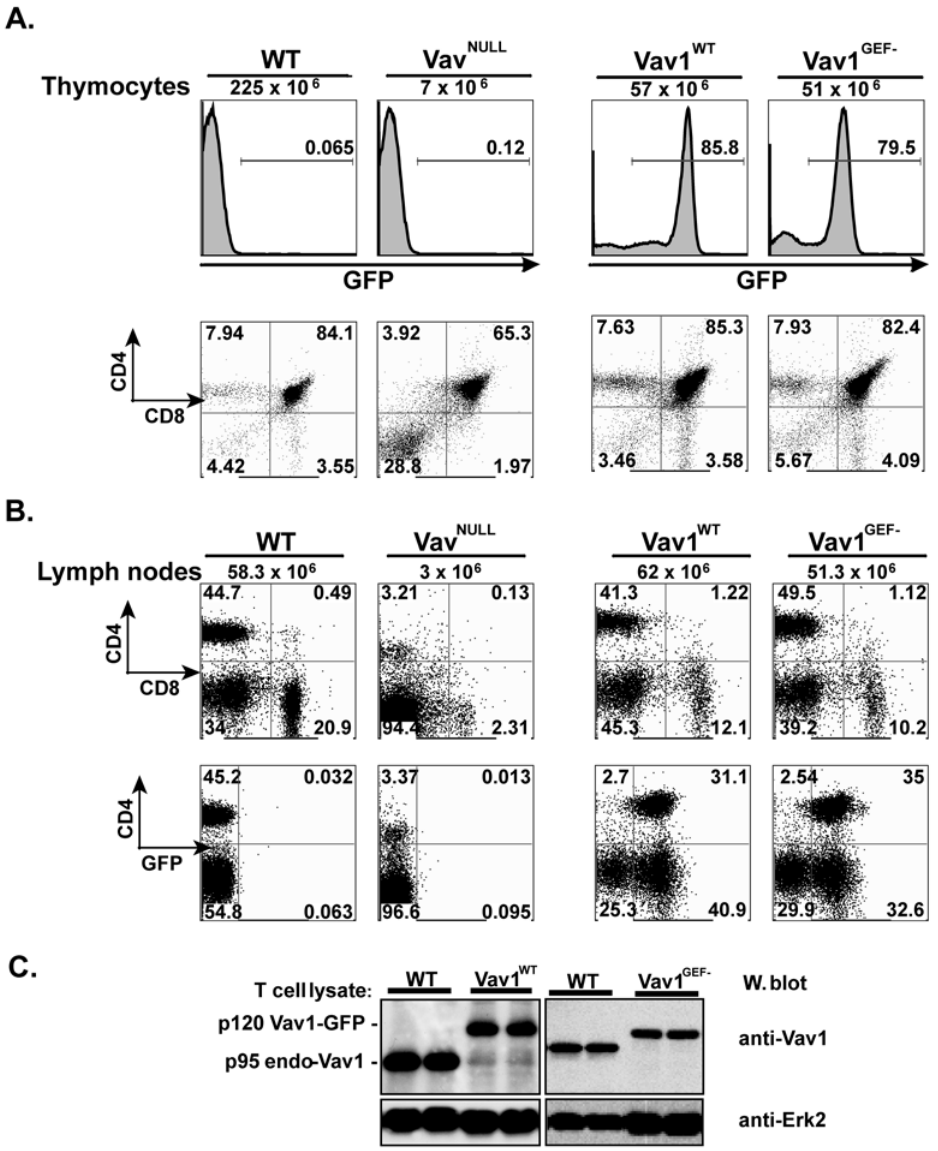
Figure 4. Expression of Vav1 GEF 2 restores Vav NULL T cell development. (A) Flow cytometric analyses of thymocytes from WT, Vav NULL , Vav1 WT and Vav1 GEF 2 mice. The bottom panel is GFP + -gated, shown is one representative of n . 5 mice. (B) Flow cytometric analyses of WT, Vav NULL , Vav1 WT , or Vav1 GEF 2 lymph nodes as in (A). The top panel is GFP + -gated, shown is one representative of n . 5 mice. (C) Expression of Vav1 WT and Vav1 GEF 2 proteins in T cell lysates, visualized by immunoblotting with anti-Vav1 antibodies. Protein loading was verified by reprobing blots with antibodies to Erk2.